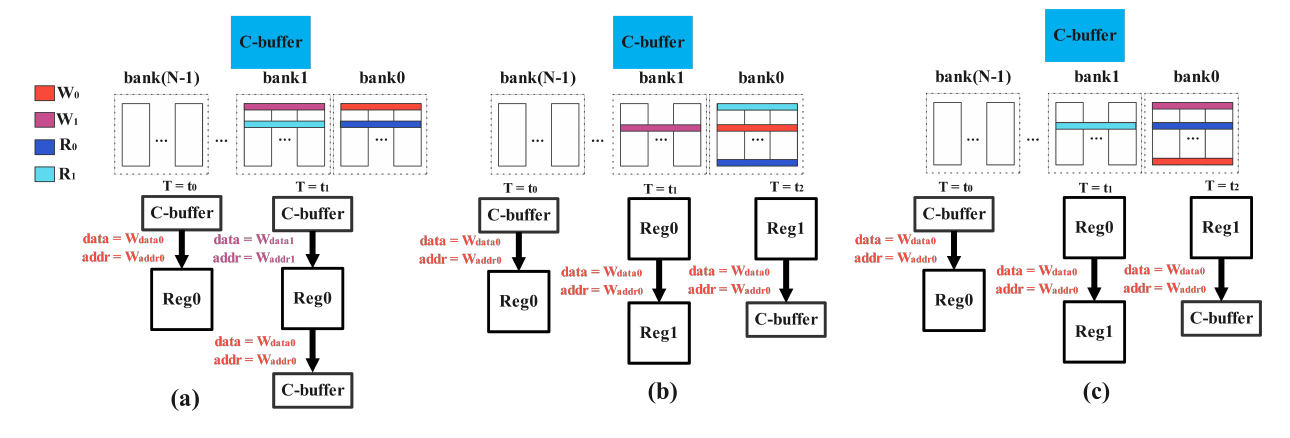
Figure 6. The several type of conflicts of memory access.